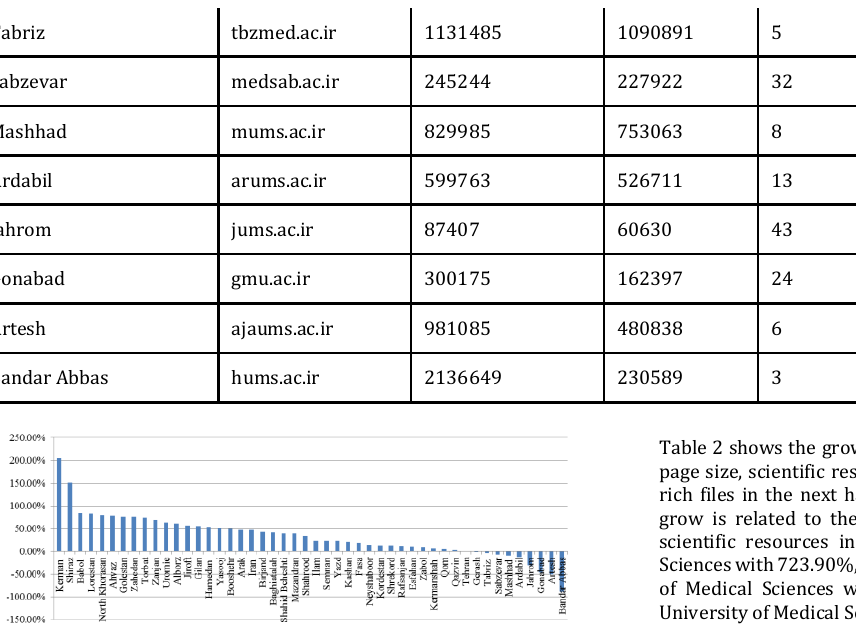
Figure 1: The growth rate of the website of Iranian medical universities in the over six-month period Table 2: The growth rate of the website of Iranian medical sciences universities in each of the Webometrics indices in the 6-month period, respectively, in letters